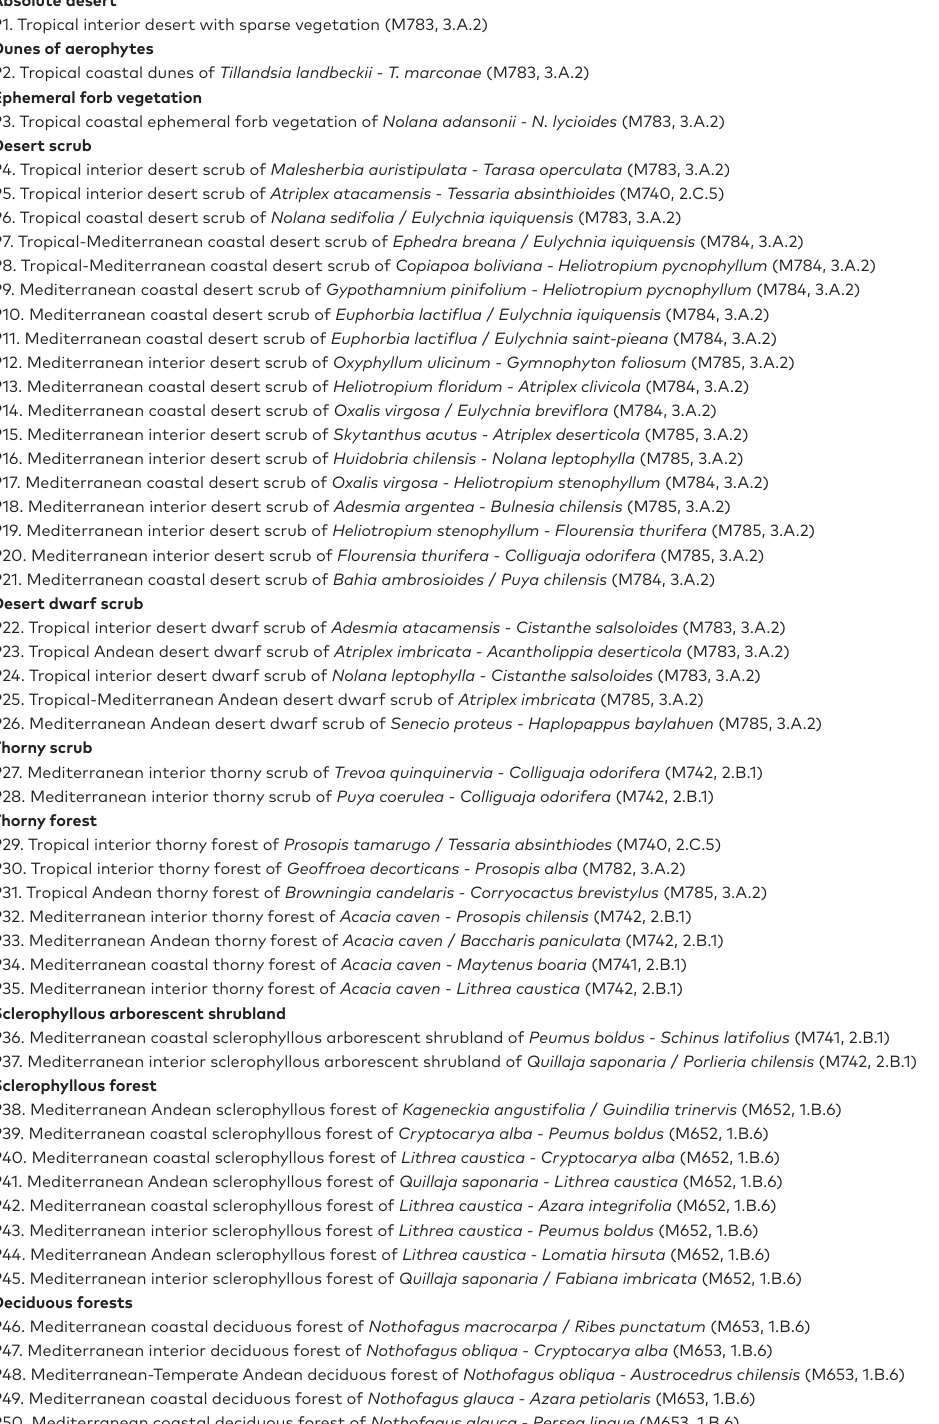
Table A1. List of the formations (in bold) and zonal units of Luebert and Pliscoff (2017) with unit codes (P1–P125) and corresponding IVC macrogroup and formation codes (in brackets; see also Table